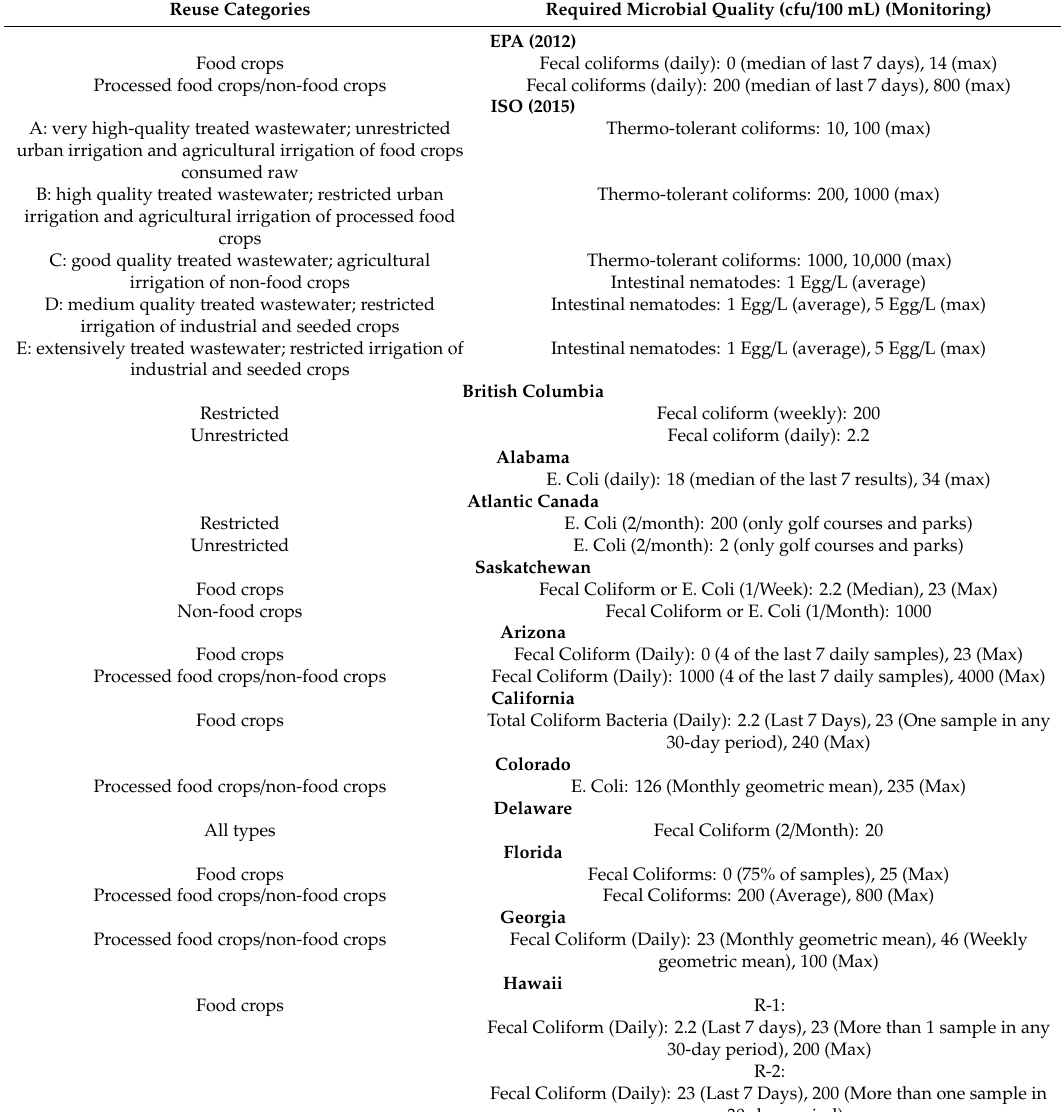
Table 4. Restrictive agricultural water reuse regulations and